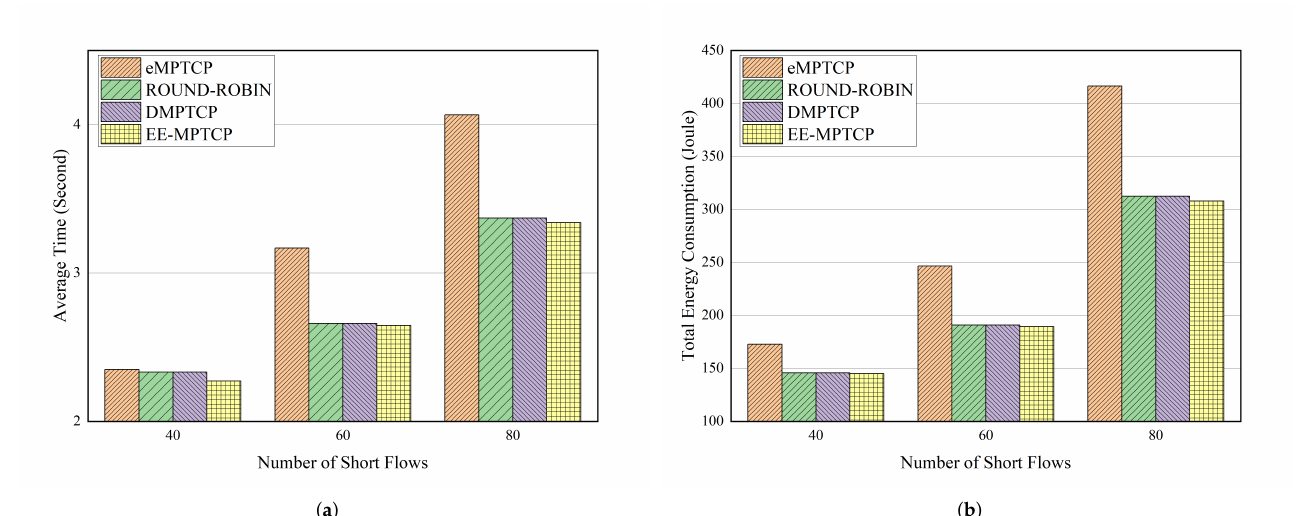
Figure 5. The evaluation results of the four algorithms, namely eMPTCP [14], the default ROUND- ROBIN, DMPTCP [27] and the proposed EE-MPTCP with varying number of short flows that transmitted concurrently in the network environment that consists of one LTE path and one WLAN path. ( a ) The average completion time of all flows. ( b ) The total energy cost during the whole transmission.